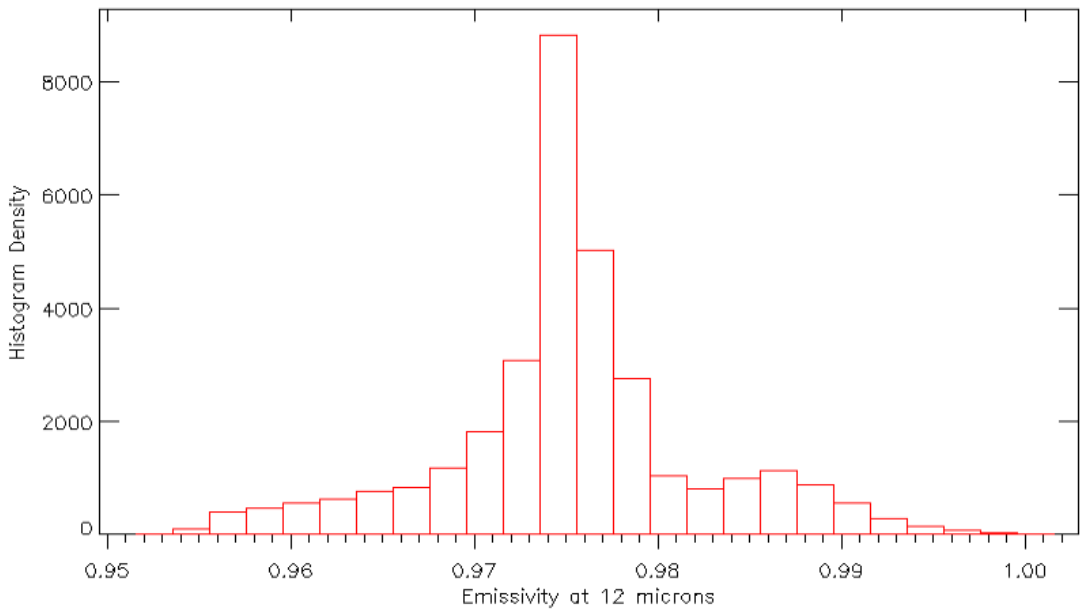
Figure 5. Histogram showing the distribution of LSE values at 12 µ m for the benchmark database.